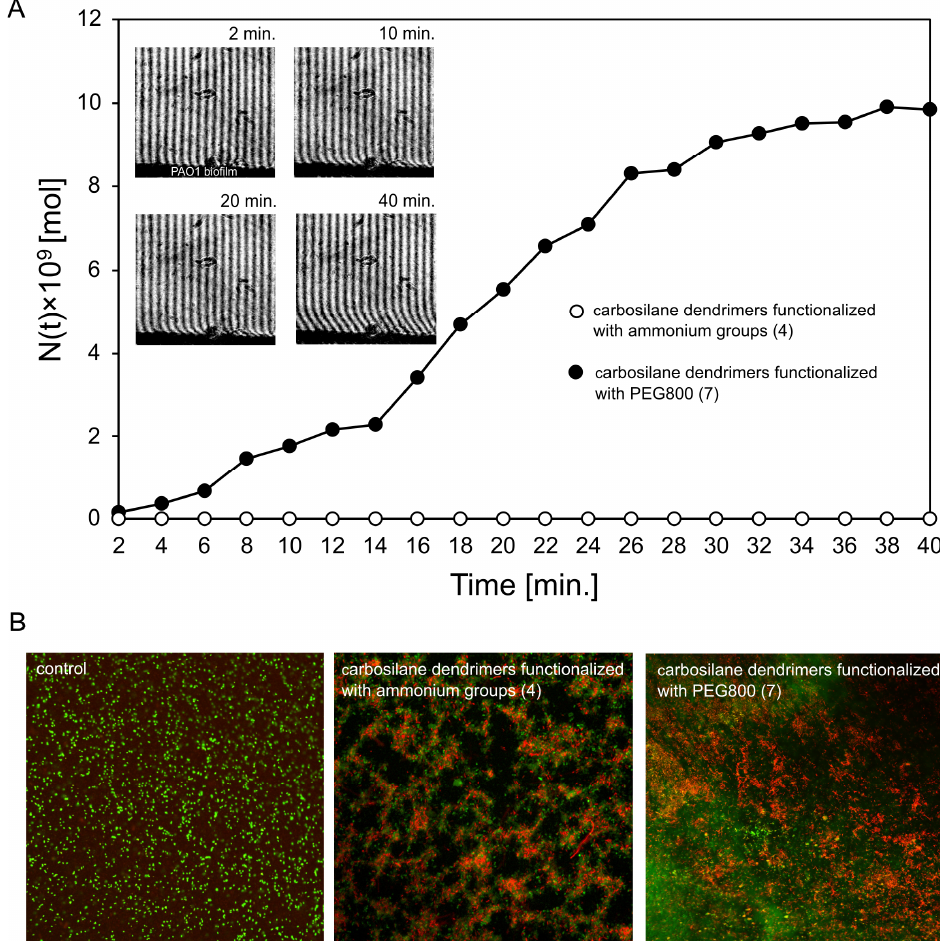
Figure 4. The diffusion of CBS dendrimers (compounds 4 and 7 ) through P. aeruginosa PAO1 biofilm layer determined by the laser interferometry ( A ). The examples of interferograms for compound 7 are presented above the diffusion curve. ( B ) The fluorescence microscopy images of PAO1 biofilm after treatment with dendrimers ( 4 and 7 ). Bacterial cells with green fluorescence are interpreted as alive, whereas bacteria with damaged membranes show red fluorescence.